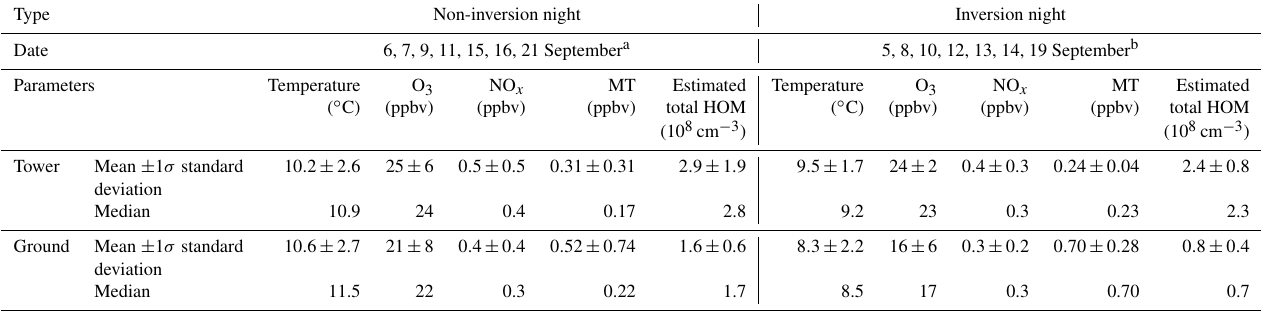
Table 1. Summary of the “Non-inversion night” and “Inversion night” types.